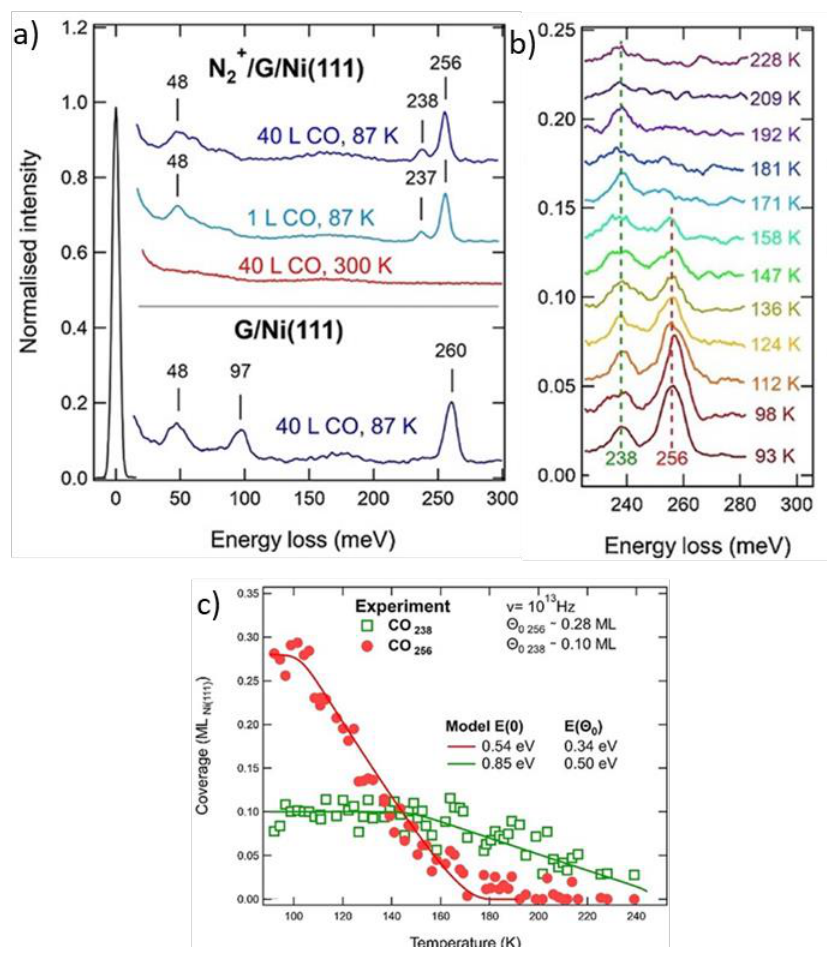
Figure 9. ( a ): HREEL spectra recorded in specular after dosing CO on pristine graphene on Ni(111) at 87 K (blue, lower spectrum), N-doped G/Ni(111) at RT (red, middle trace), N-doped G/Ni(111) at 87 K (blue, top traces). ( b ): Thermal evolution of the HREEL spectra of the N-doped graphene after exposure to CO at 87 K. ( c ): Intensity of the 234 meV and 256 meV peaks vs. annealing temperature. Taken with permission from Ref. [21]. Copyright by Elsevier.